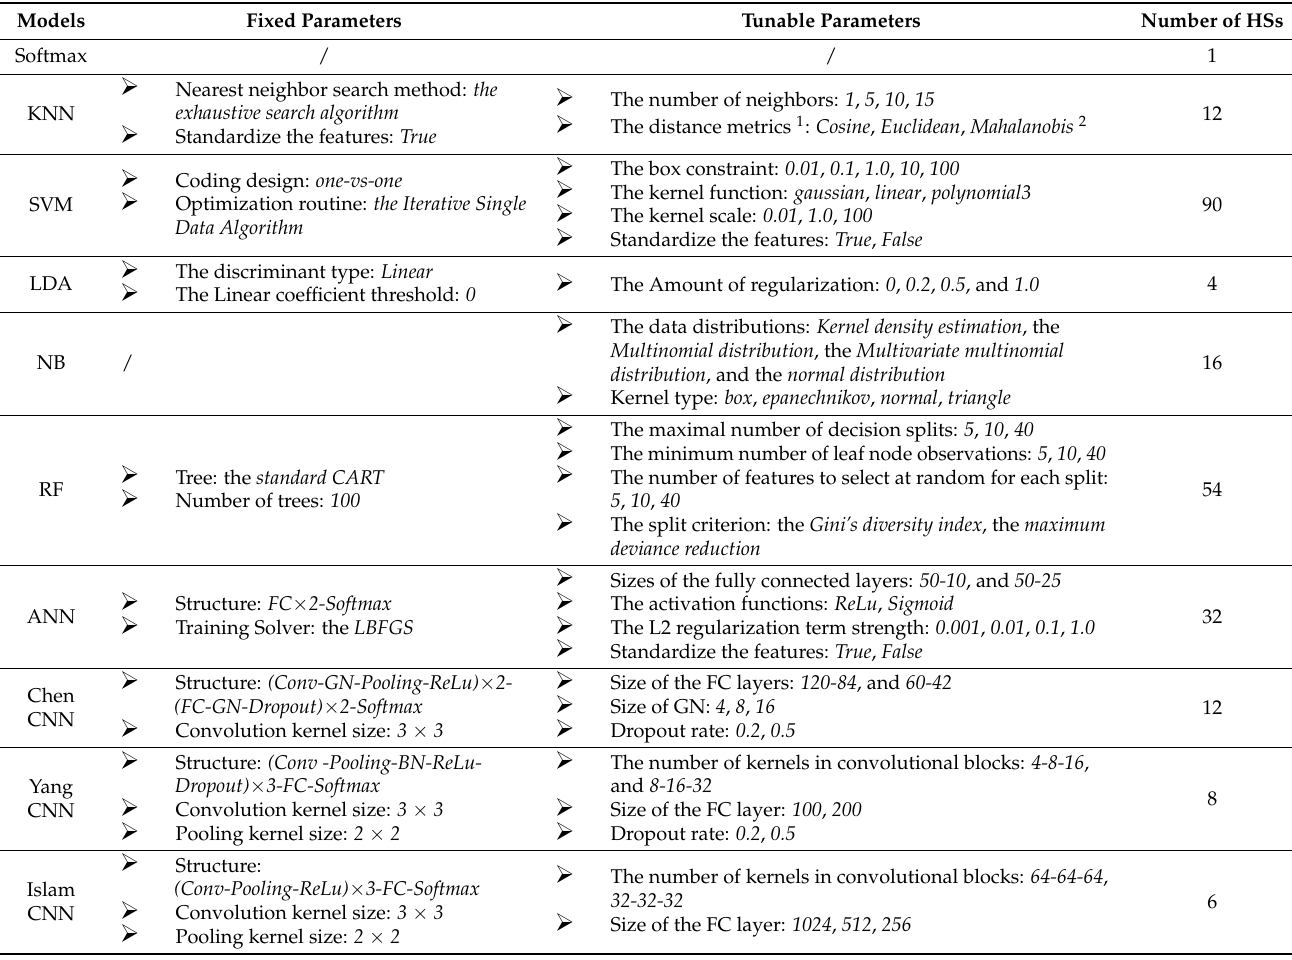
Table 4. Hyperparameter settings of the ten